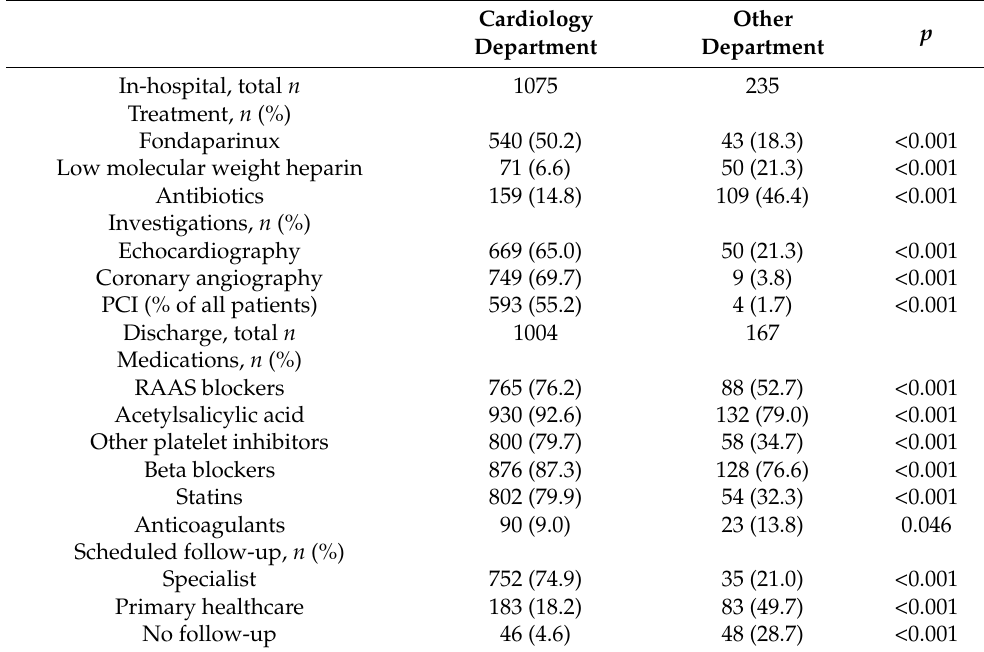
Table 3. Investigations, treatment and follow up.